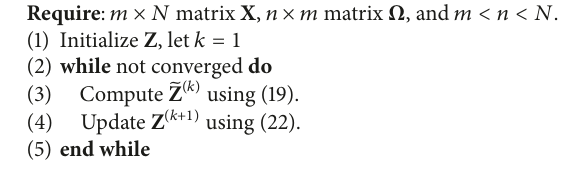
Algorithm 2: Sparse coding based on DC programming